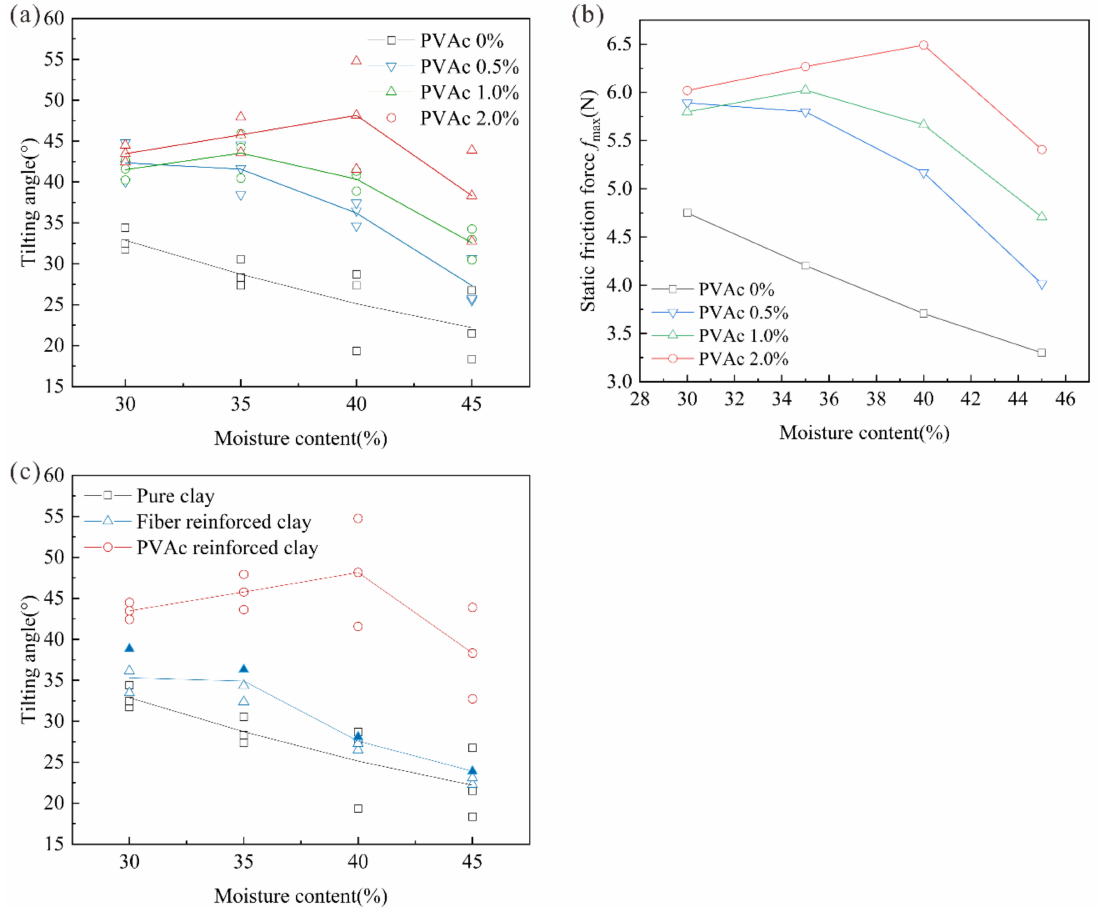
Figure 5. Model test result of PVAc-reinforced clay: ( a ) The tilting angle of clay sample; ( b ) Maximum static friction of clay sample; ( c ) The tilting angle range of differently reinforced